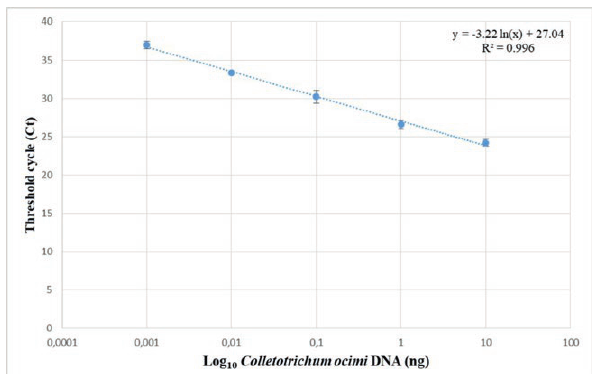
Figure 4. Standard curve obtained with Colletotrichum ocimi genomic DNA (strain CVG190). The Ct values were plotted against the C. ocimi DNA concentrations (from 10 ng µL -1 to 1 pg µL -1 ). Standard deviation bars, the linear regression equation and the R 2 value are displayed on the graph. The dilutions were run in